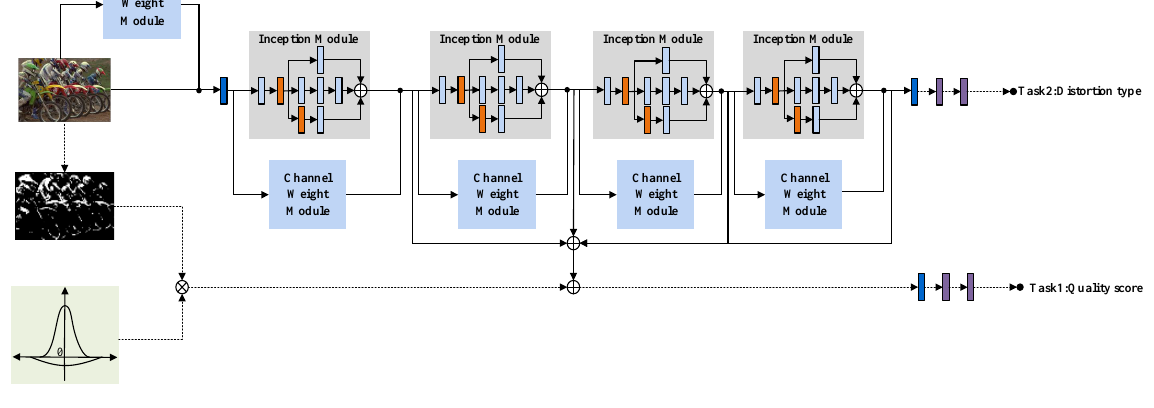
Figure 5. The overall framework of the model.